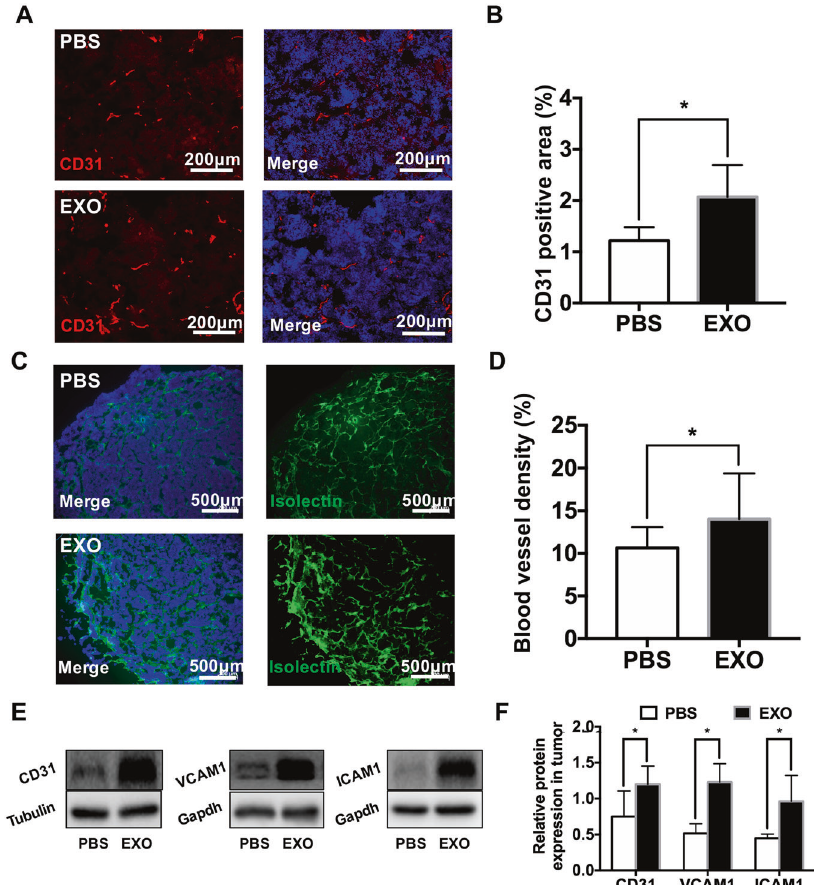
Fig. 4 Exosomes derived from WERI-Rb1 cells increase retinoblastoma angiogenesis in vivo. A Immuno fl uorescence analysis of CD31- positive cells showed that the capillary density in the EXO-injected group was increased. Bar = 200 μ m. B Quanti fi cation of the CD31-positive area (%) in the tumors ( n = 5, * P < 0.05). C Immuno fl uorescence analysis of the isolectin positive areas. Bar = 500 μ m. D Quanti fi cation of isolectin positive area (blood vessel density, %) in the tumors ( n = 7, * P < 0.05). E Western blot images showing the protein levels of CD31, VCAM1, and ICAM1 in tumors from the PBS-injected group and EXO-injected group. F Relative quanti fi cation of protein expression in tumors ( n = 6, * P <